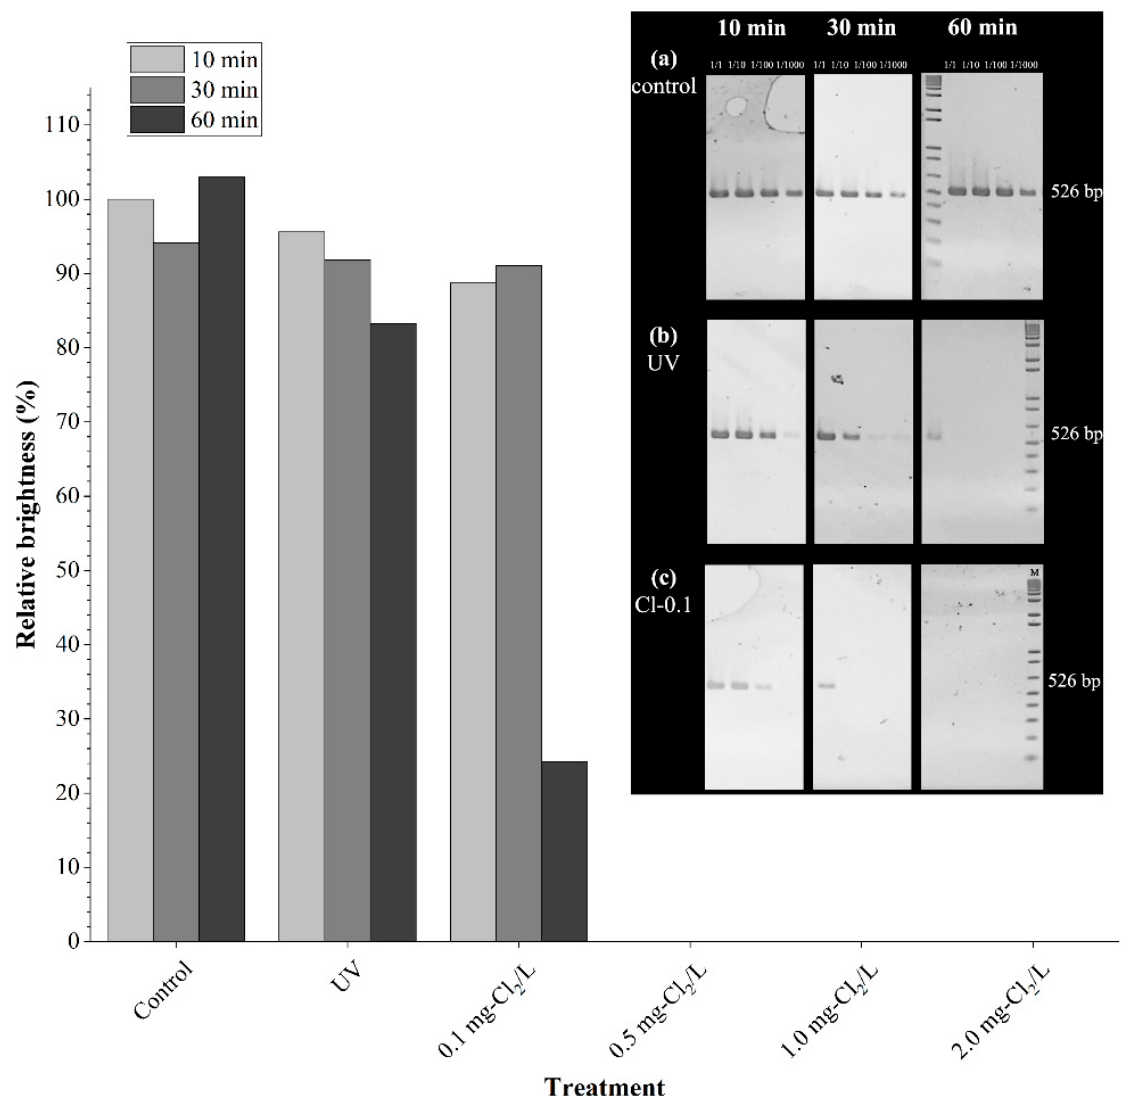
Figure 2. Relative brightness of treated pUC19 PCR products in 1.5% agarose gel electrophoresis. Right image shows the bands of the electrophoresed PCR products: ( a ) control; ( b ) UV; ( c ) 0.1 mg-Cl 2 /L.